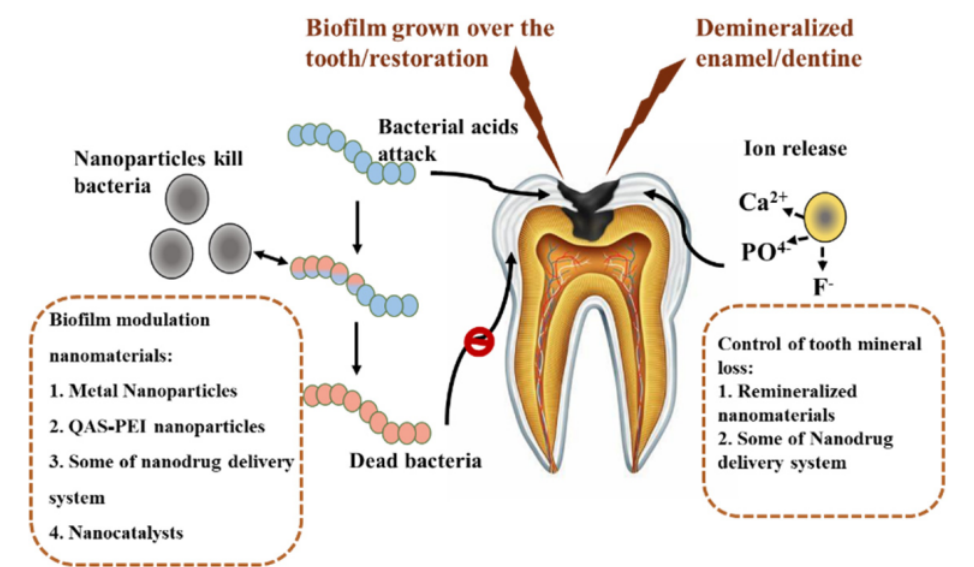
Figure 2. Schematic is indicating the roles of anti-caries